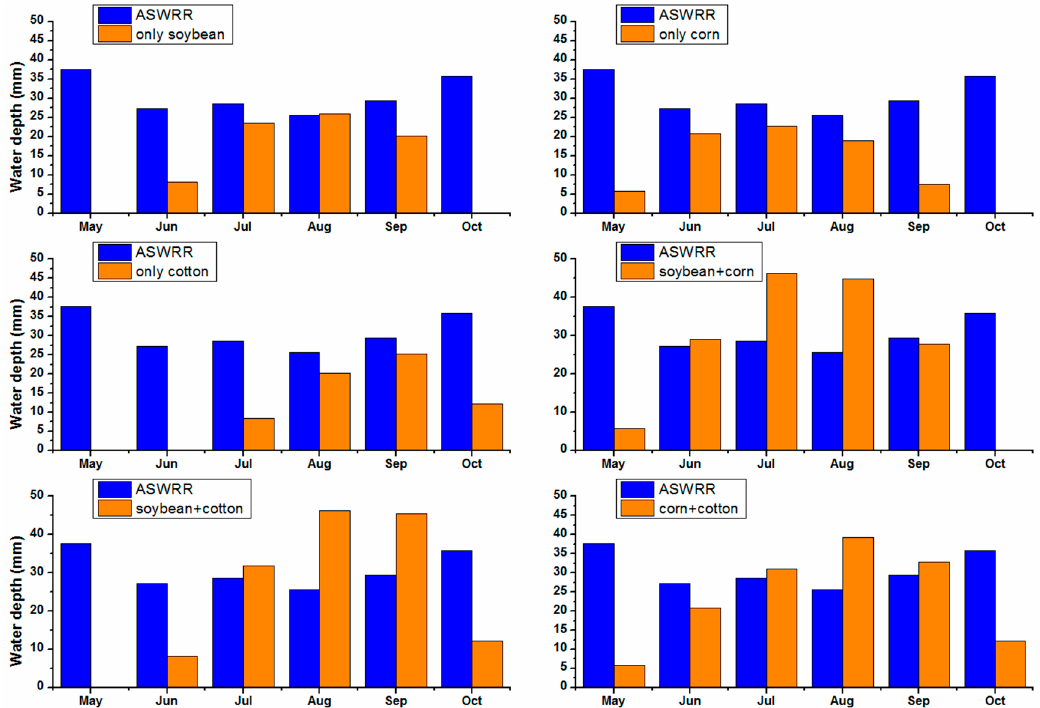
Figure 6. The relationship between crop irrigation demands and the sum of ASWR and rainfall under six di ff erent land use scenarios. * ASWR is defined as: ASWR = 80% SWRP + PWRP; SWRP is defined as: SWRP = SWR − (SE + ST); SWR is stream water resources, SE is stream water evaporation, ST is stream transmission; PWRP is defined as: PWRP = PWR − PE; PWR is pond water resources; PE is pond water